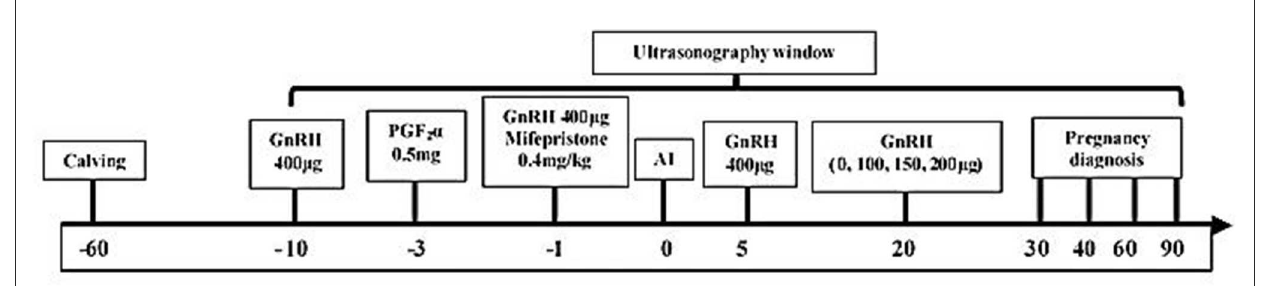
FIGURE1 Layout describing the schedule of synchronization protocol, ultrasound monitorings, AI, post-AI hormonal treatments, and pregnancy diagnosis in